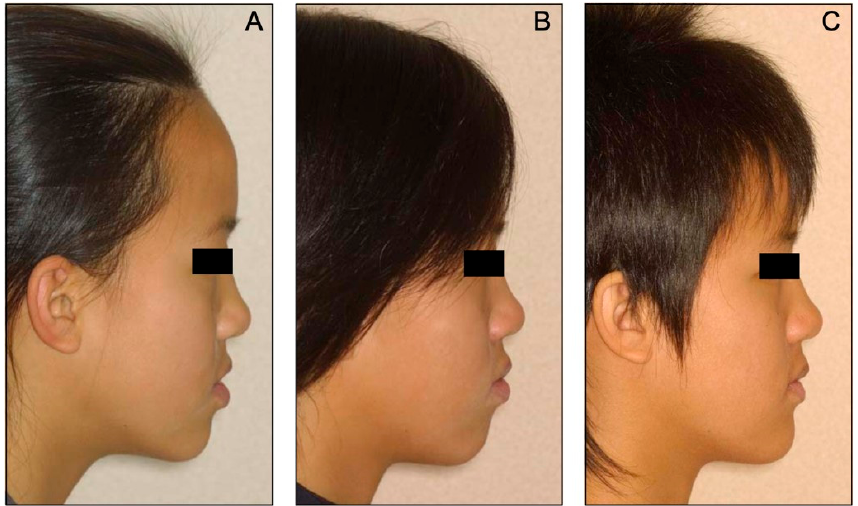
Figure 7. Case 1, Cephalometric superimpositions show the correction of anterior crossbite and Class III malocclusion with four premolar extraction approach.